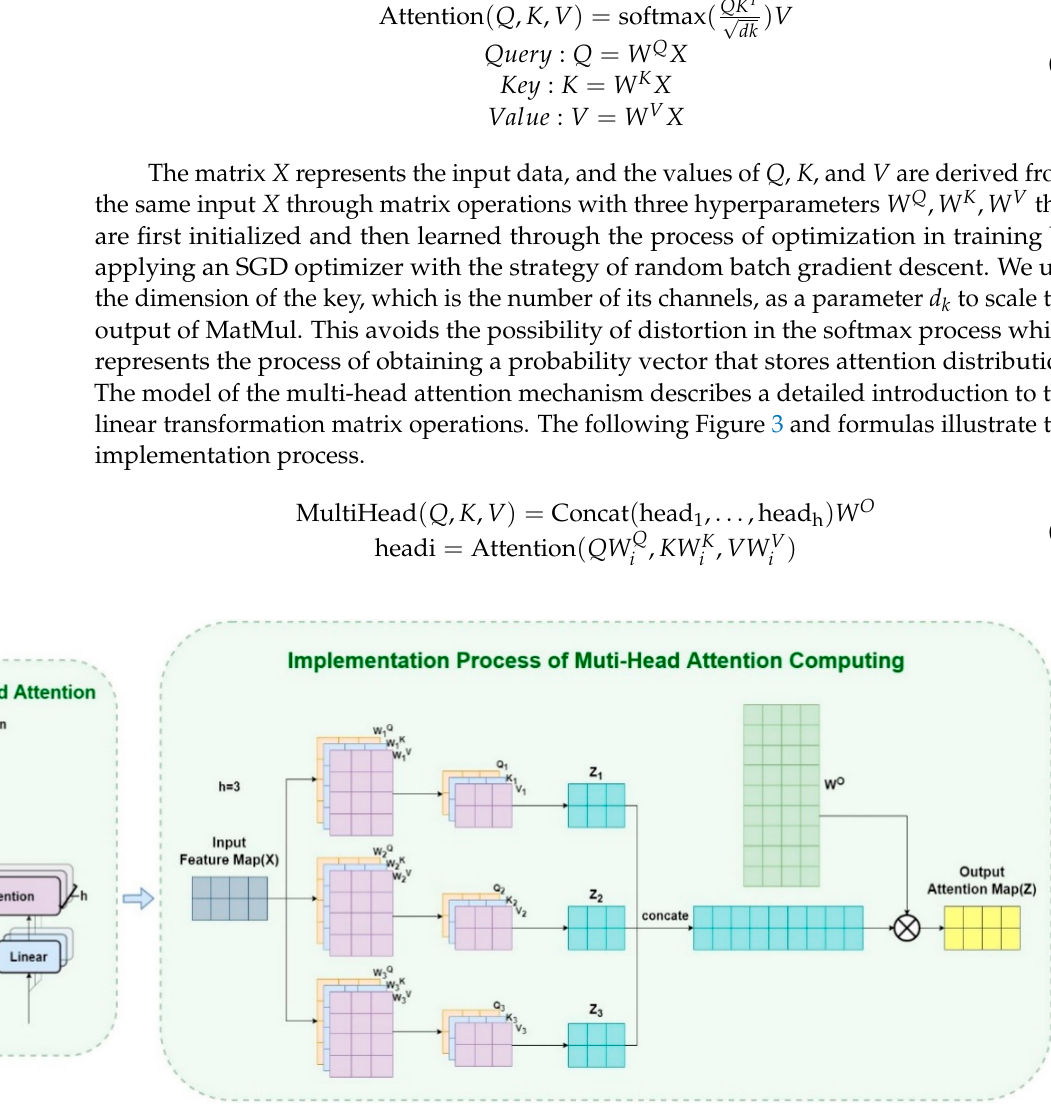
Figure 2. A typical self-attention mechanism implementation process where MatMul represents the dot product operation of the input matrix Q and K.